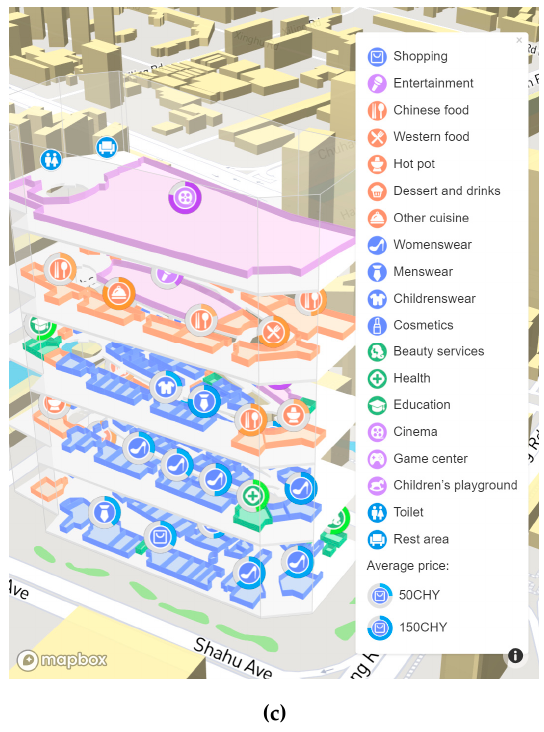
Figure 9. Results of scale-adaptive indoor map: ( a ) at a smaller scale, the main function of each floor and class-level symbols are shown; ( b ) at a medium scale, the functional divisions of each floor and subclass-level symbols are shown; ( c ) at a larger scale, the detailed room distributions and POI symbols with rich semantic information are shown.